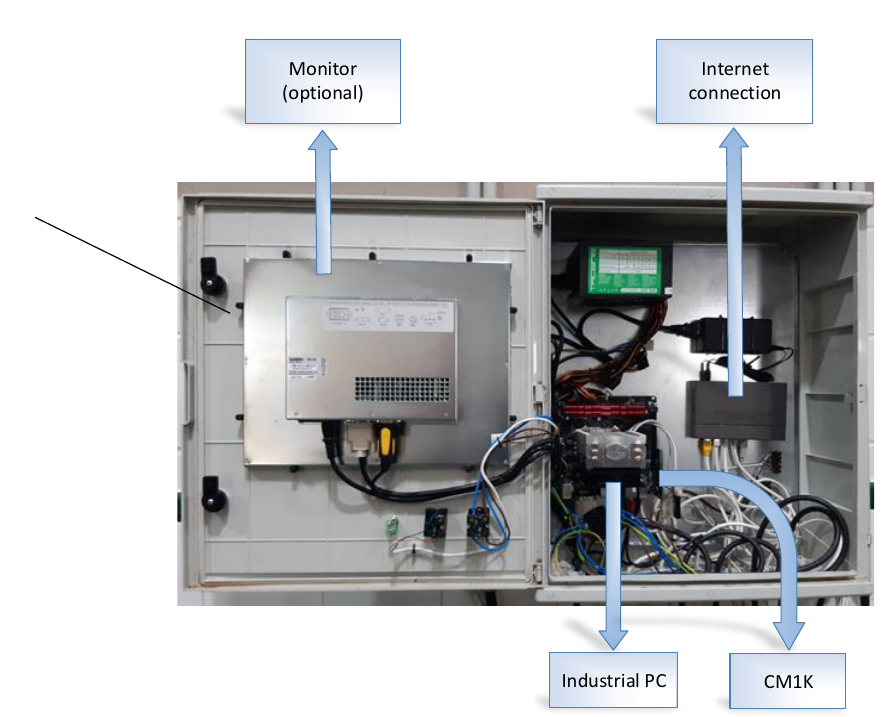
Figure 7. Electronic circuit of the PC with CM1K chip.